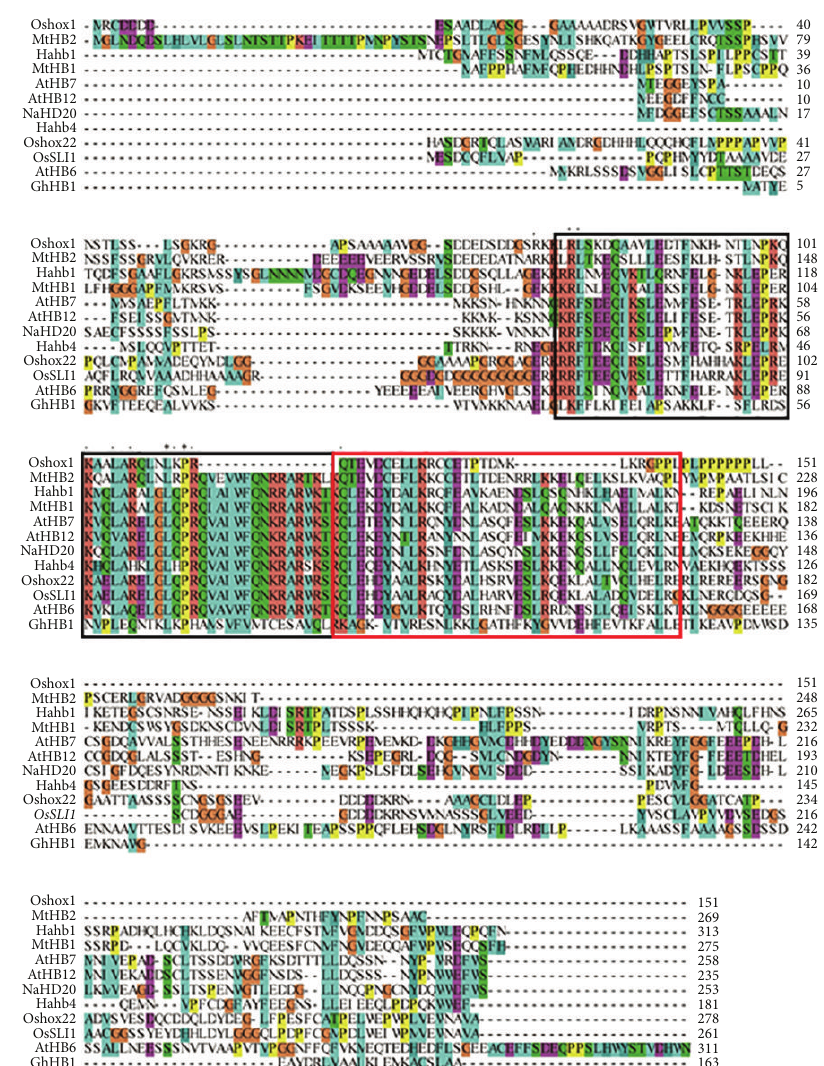
Figure 1: Sequence alignment of stress-related HD-Zip proteins in plants. The HD domain and Zip domains are boxed in black and red, respectively. GenBank accession numbers for the sequences: AtHB6 (AT2G22430), AtHB7 (AT2G46680), AtHB12 (AT3G61890), GhHB1 (EF151309), Hahb1 (AAA63765), Hahb4 (AAA63768), MtHB1 (ABO47743), MtHB2 (ACJ84212), NaHD20 (HM107874), Oshox1 (AAG13598), Oshox22 (AAO72559), and OsSLI1 (NP